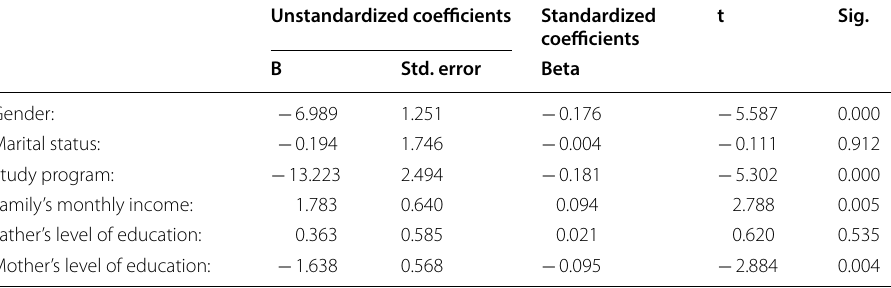
Table 7 Coefficients for socio-economic variables and total questionnaire responses Unstandardized